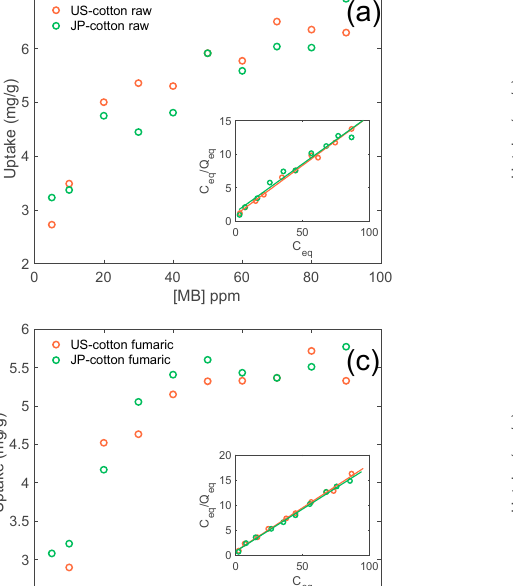
Table 3. Comparison of TCC values obtained by different reported methods.